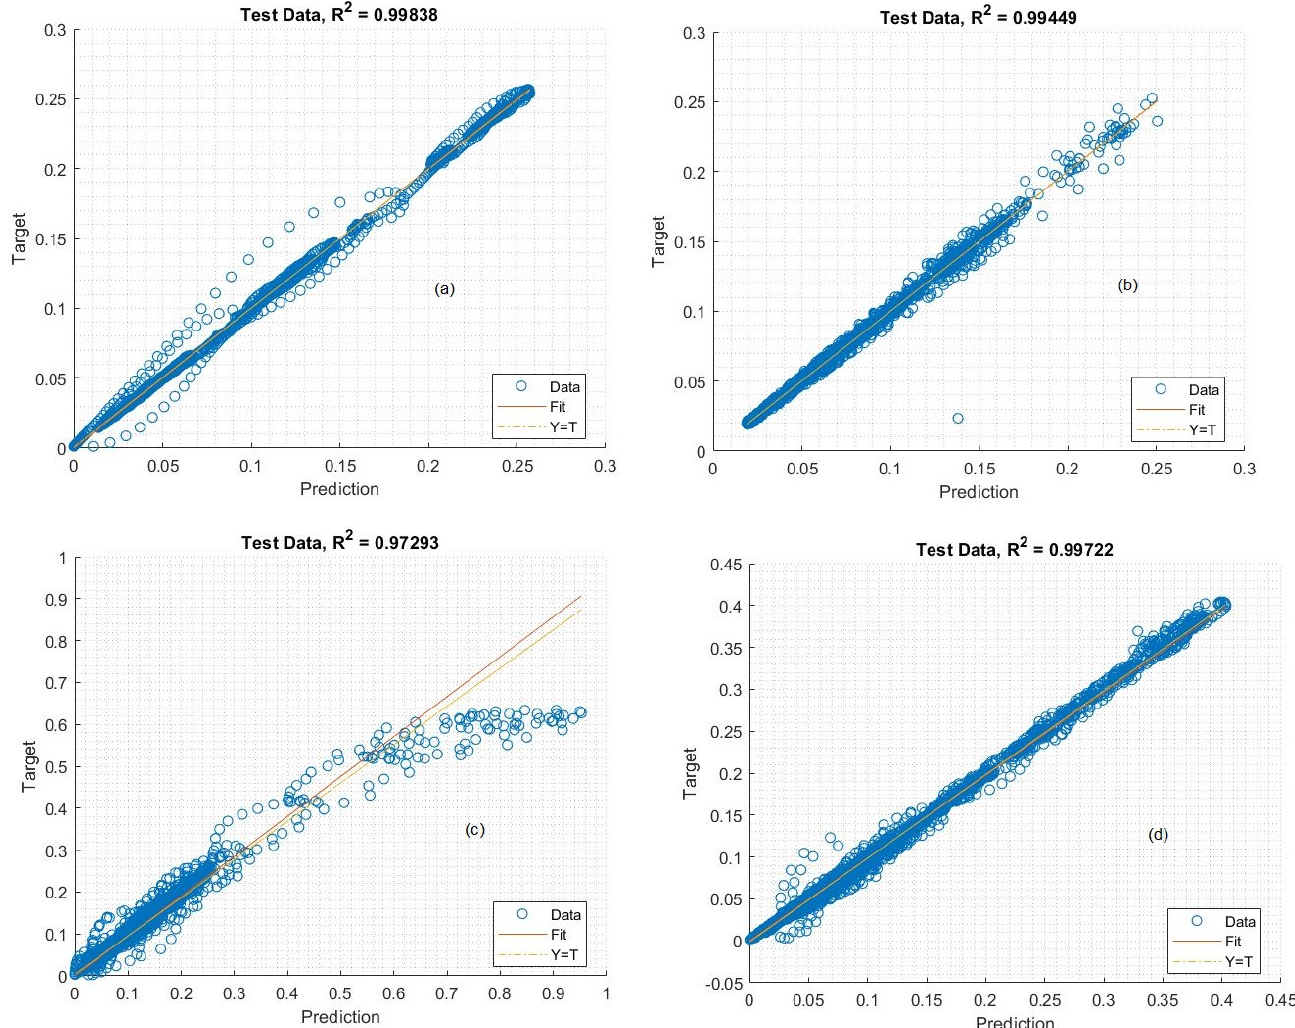
Figure 19. Regression plot of MLP for predicting stock markets in Saudi Arabia in the training phase, ( a ) communication ( b ) energy, ( c ) financial and ( d ) industrial sectors.